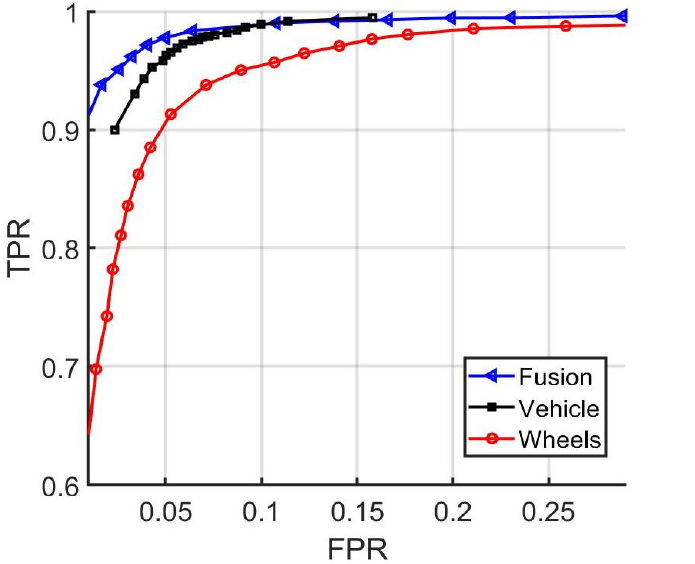
Figure 10. ROC curves comparing the performances of whole-vehicle-only matching, wheels-only matching, and averaging-based decision fusion of the two matching